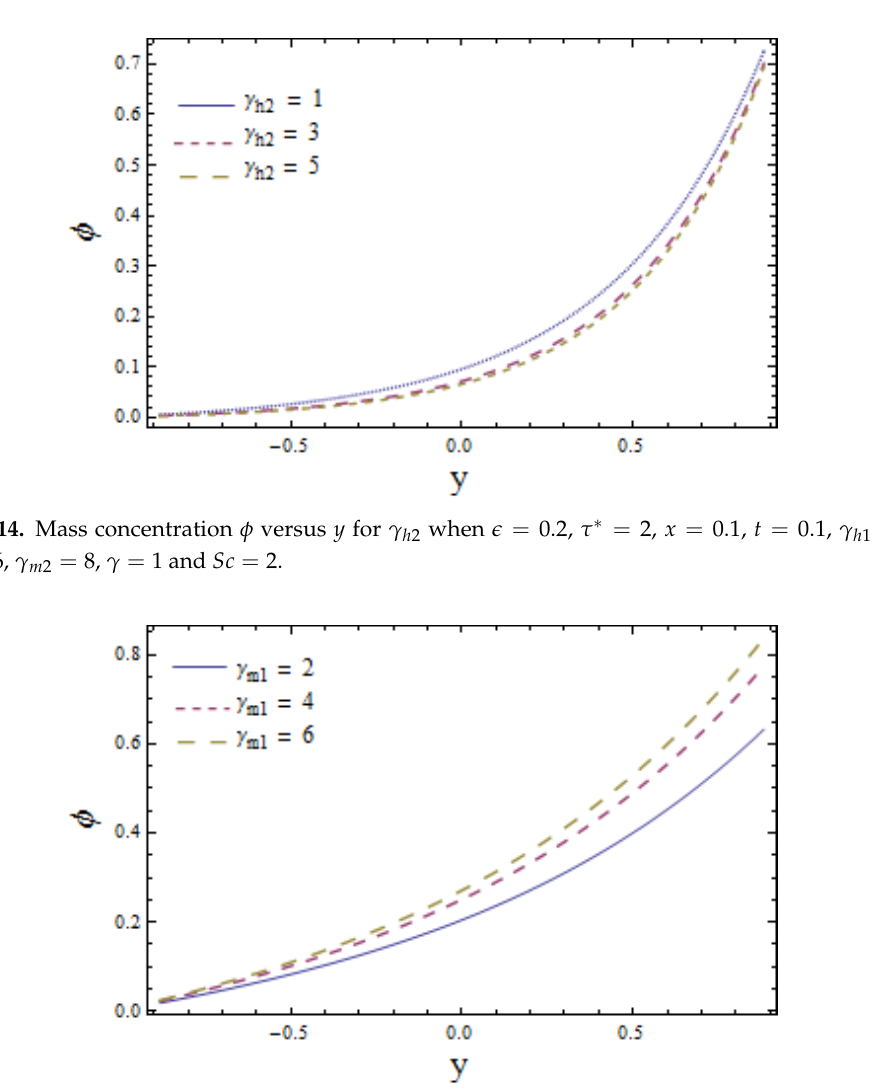
Figure 13. Mass concentration φ versus y for γ h 1 when (cid:101) = 0.2, τ ∗ = 2, x = 0.1, t = 0.1, γ h 2 = 8, γ m 1 = 6, γ m 2 = 8, γ = 1 and Sc = 2.